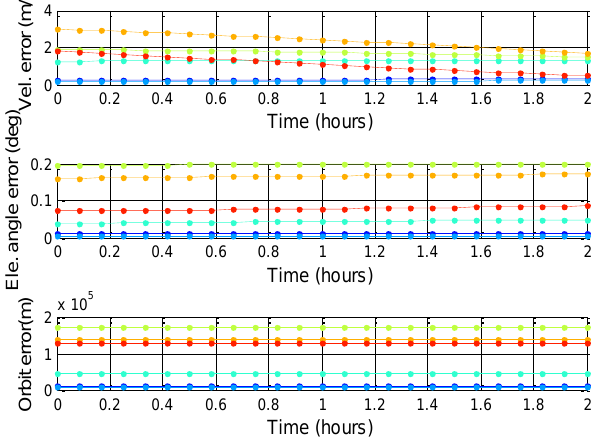
Figure 22. BDS DQA1: BDS GEO almanac using period test for five weeks.